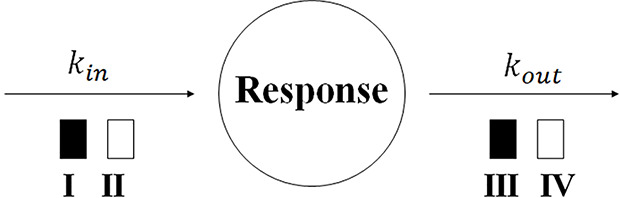
Indirect response model structure. kin and kout represent the first-order production constant and the first-order dissipation rate constant of the response, respectively. The open and solid box represents the inhibitory and stimulatory effect, respectively.